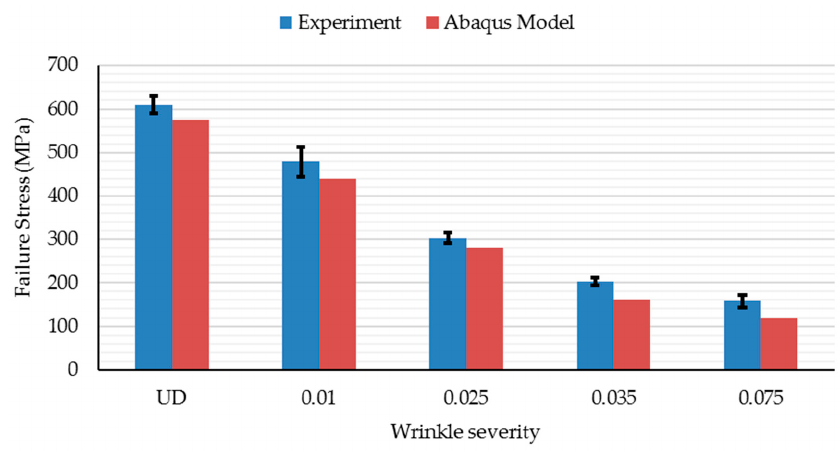
Figure 11 . Comparison of compressive strength of GFRP laminates with different wave